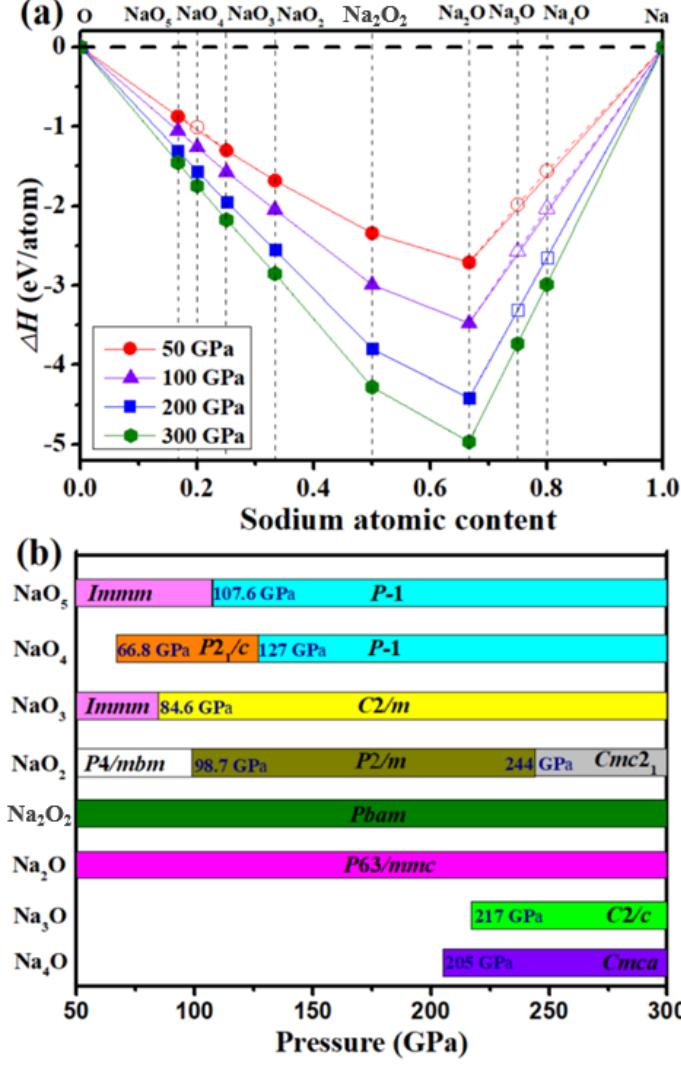
Figure 1. ( a ) Calculated formation enthalpy ( Δ H ) for each Na x O y composition relative to O and Na at 0 K. Solid symbols represent stable compounds, and open symbols represent metastable compounds. ( b ) Pressure range and structure of each stable compound. Na adopted the following structures: Na − bcc, Na − fcc, Na − cI16, Na − oP8, and Na − hP4 [29,48–51], and O adopted ζ phases with C 2 /m symmetry [52].